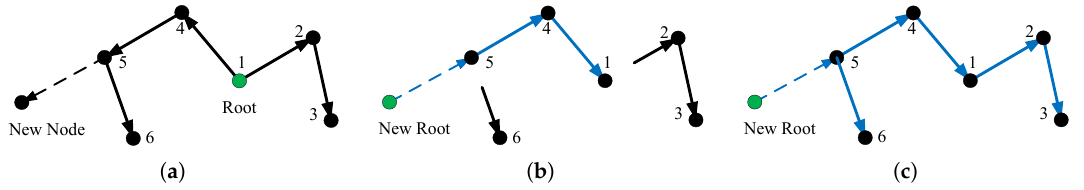
Figure 6. The process of changing the root of a tree. ( a ) The original state. ( b ) After traceback, the connection order from the new point to the root is reversed. ( c ) After re-attach, other branches connect to the main branch, and the switch of the root node is completed.